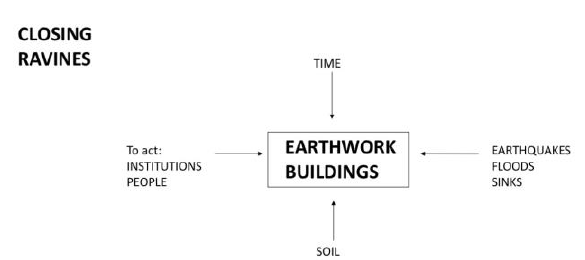
Figure 9. Relation between Ravines filling and built-up heritage. Credits: Dario Giordanelli.